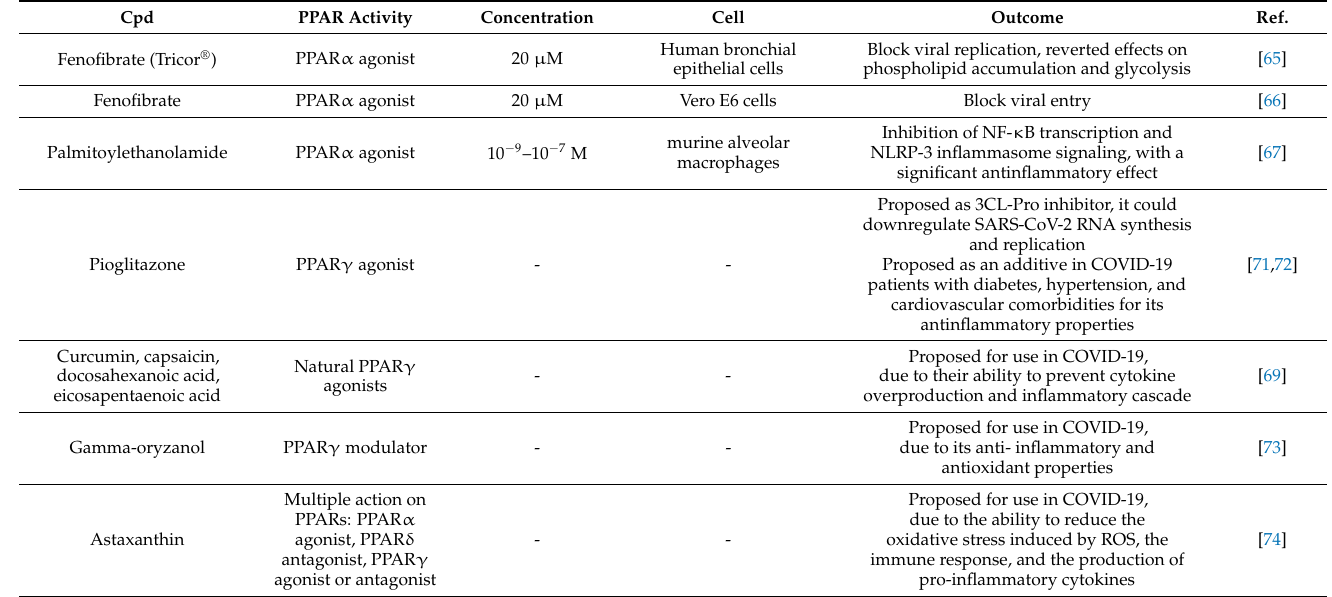
Table 1. Summary of PPAR ligands in vitro tested in SARS-CoV-2 infection or proposed as anti-SARS- CoV-2 agents.